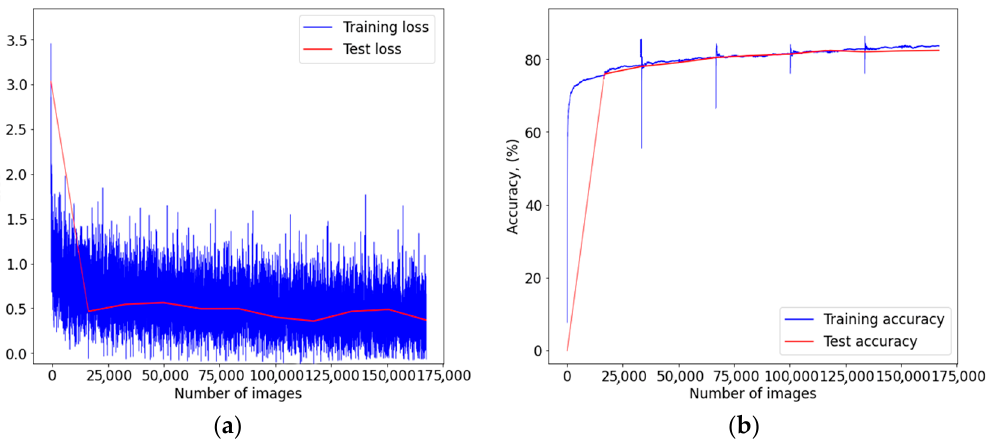
Figure A1. Graph of learning outcomes of a multimodal neural network system for classifying der ‐ matoscopic images of pigmented skin lesions based on CNN AlexNet: ( a ) loss function; ( b ) recogni ‐ tion accuracy.